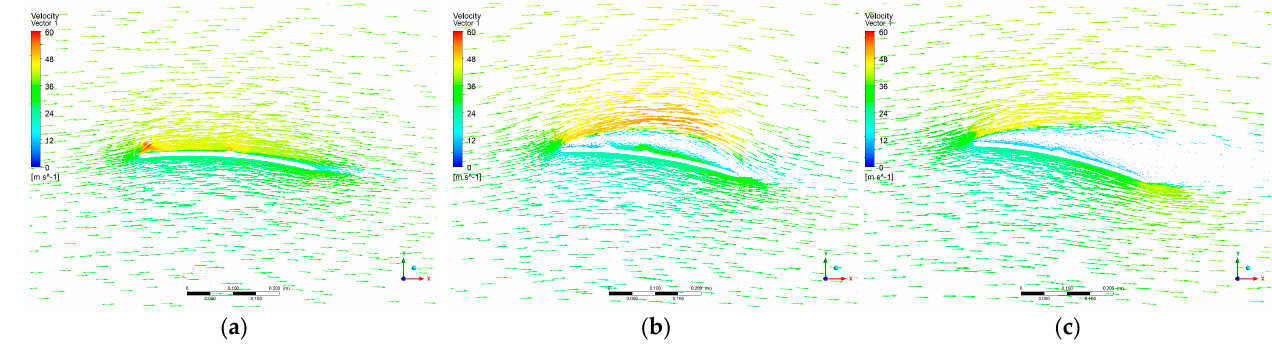
Figure 10. Velocity vector of proposed airfoil at Re of 600,000. ( a ) Angle of attack of 4°; ( b ) angle of attack of 8°; ( c ) angle of attack of 12°.